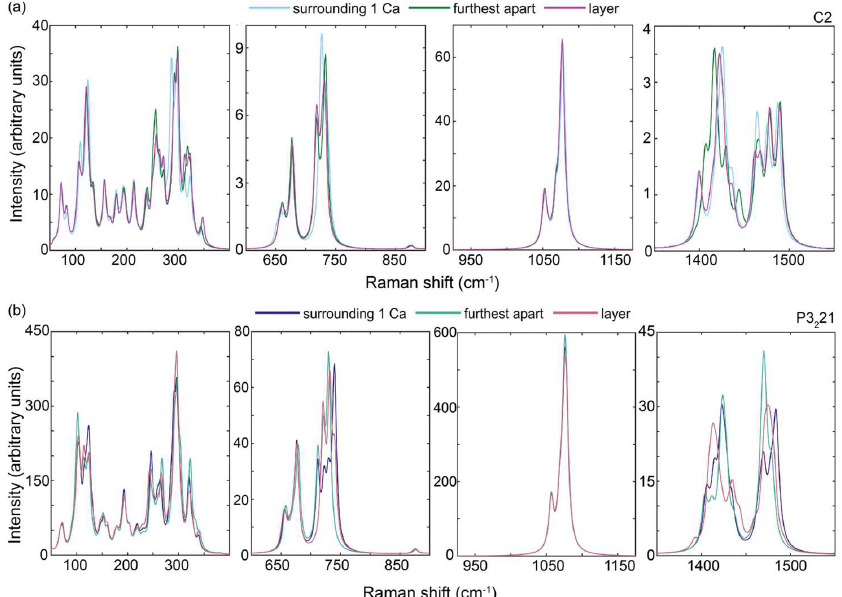
Figure 6. Calculate band shifts and intensity changes associated with the distribution of 18 O in C 16 O 218 O vaterite Raman spectra: ( a ) C2 structure and ( b ) P3 2 21 structure. The regions outside of the plotted areas have no vibrational bands visible. Note that the individual spectral regions of interest are plotted with different y axes to facilitate visualization.